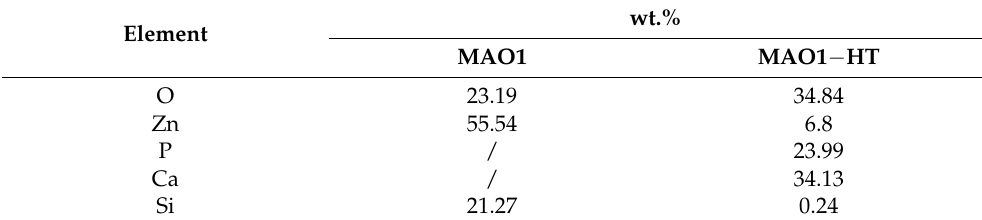
Table 1. The chemical compositions of the MAO1 and MAO1 − HT coatings in Figure 1.